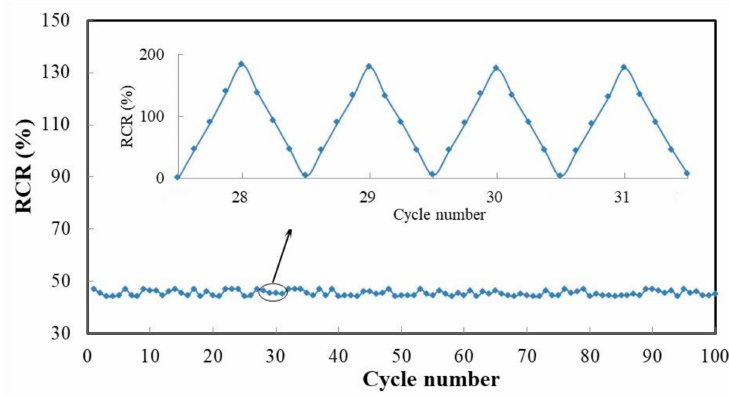
Figure 7. Gauge factor (GF) of sample 1 during 100 cycles of tension within 4% strain